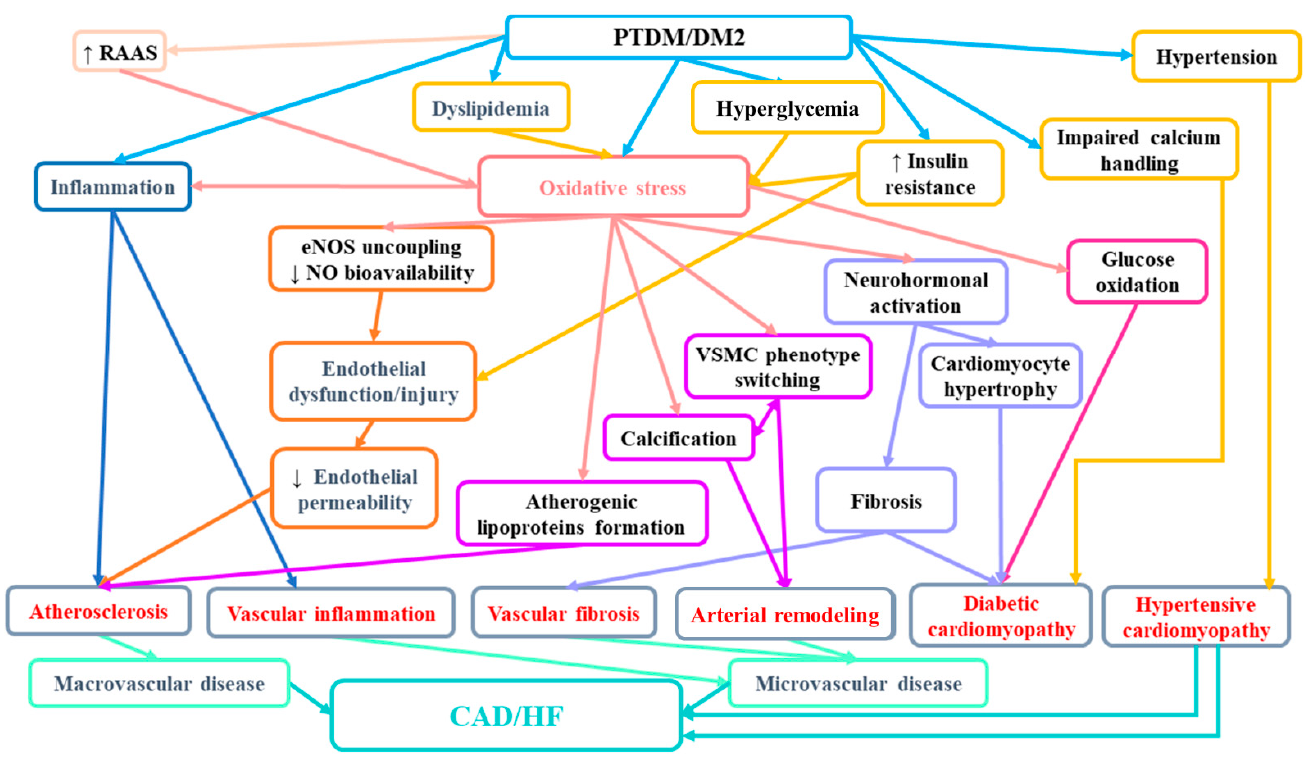
Figure 1. The suggested mechanisms involved in increased CAD/HF risk in patients with PTDM/diabetes mellitus. RAAS—renin-angiotensin-aldosterone system; eNOS—endothelial nitric synthase; NO—nitric oxide; VSMC—vascular smooth muscle cells; CAD—cardiovascular disease; HF—heart failure.